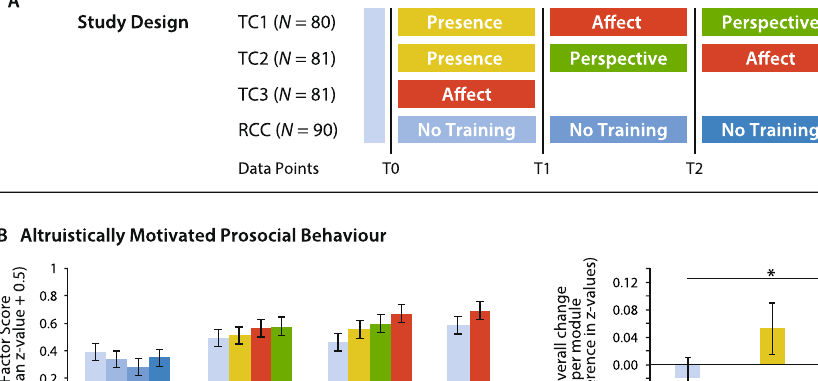
Training-induced changes on altruistically motivated behaviour were not correlated with training-induced changes in self-reported prosocial behaviour (r = − 0.02, p = 0.76). Hence, people who perceived themselves as increasingly prosocial (assessed through psychological trait questionnaires) were not necessarily the same peo- ple who behaved more altruistic in task-based assessments of prosocial behaviour. Interestingly, however, indi- vidual differences in training-induced increases in altruistically motivated behaviour were related to individual differences in norm-enforcing behaviour (r = 0.25, p = 0.000, surviving correction for multiple comparisons). This finding suggests that the more individuals increased in altruistic behaviour due to the training, the less they decreased in enforcing social norms at a cost to themselves. No other significant correlations were revealed between training-induced changes across the three factors of prosociality (all ps > 0.1). No significant relations between the factors of prosociality were revealed in the RCC (ps ≥ 0.043, not surviving correction for multiple comparisons).